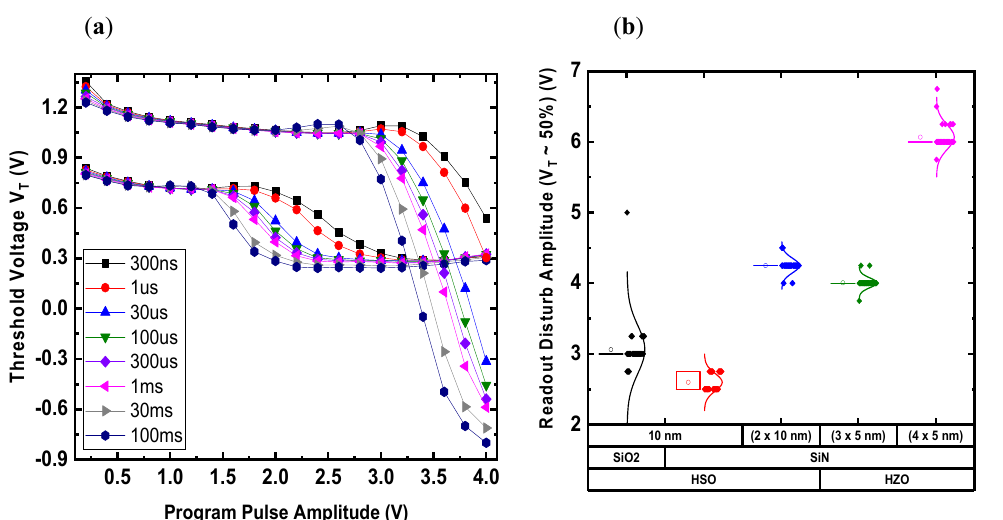
Figure 16. The impact of the applied voltage amplitude on the disturbance characteristics of the FeFET illustrated for ( a ) two different stacks of HSO (10 nm) and laminate HSO (2 × 10 nm) measured at different disturbance pulse widths, ( b ) the onset of readout disturbance amplitude for 50% V T (ER to PG transition), plotted versus the different stack/IL type.